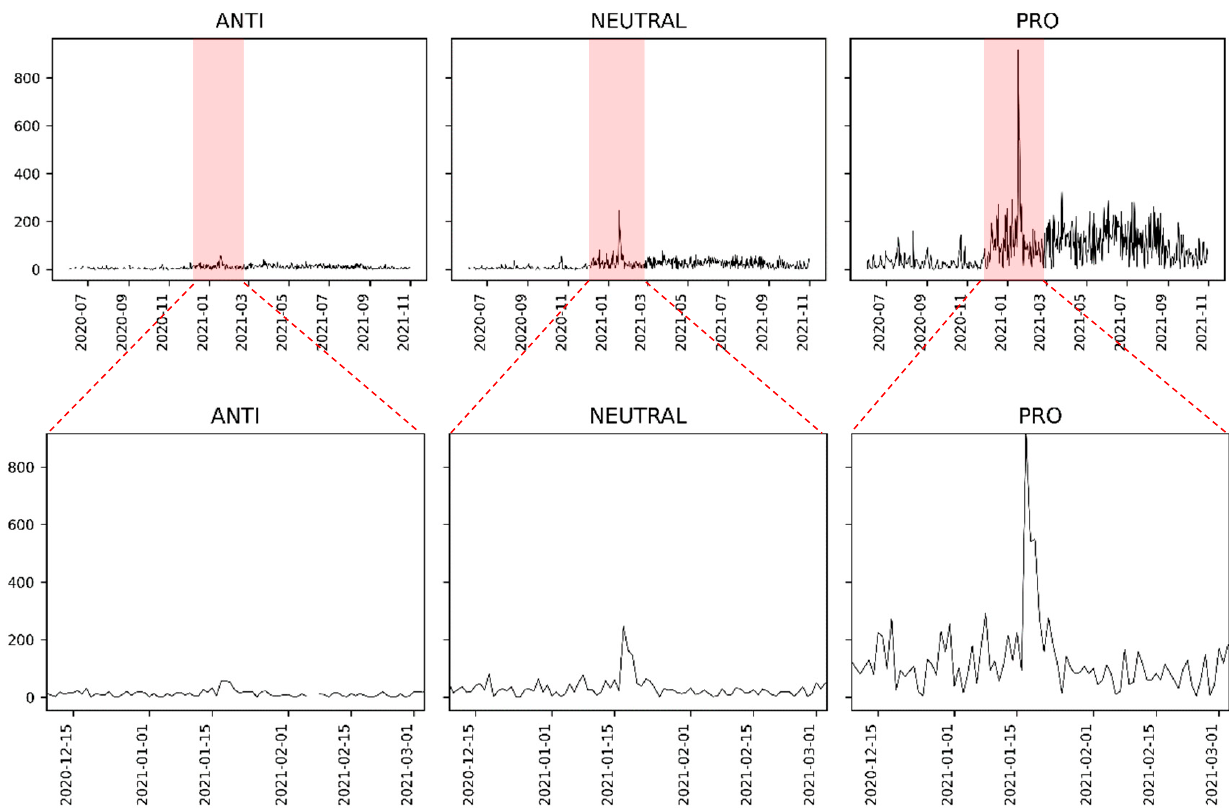
Figure 10. Timeline for each polarity, counting the number of tweets per day within the considered period.